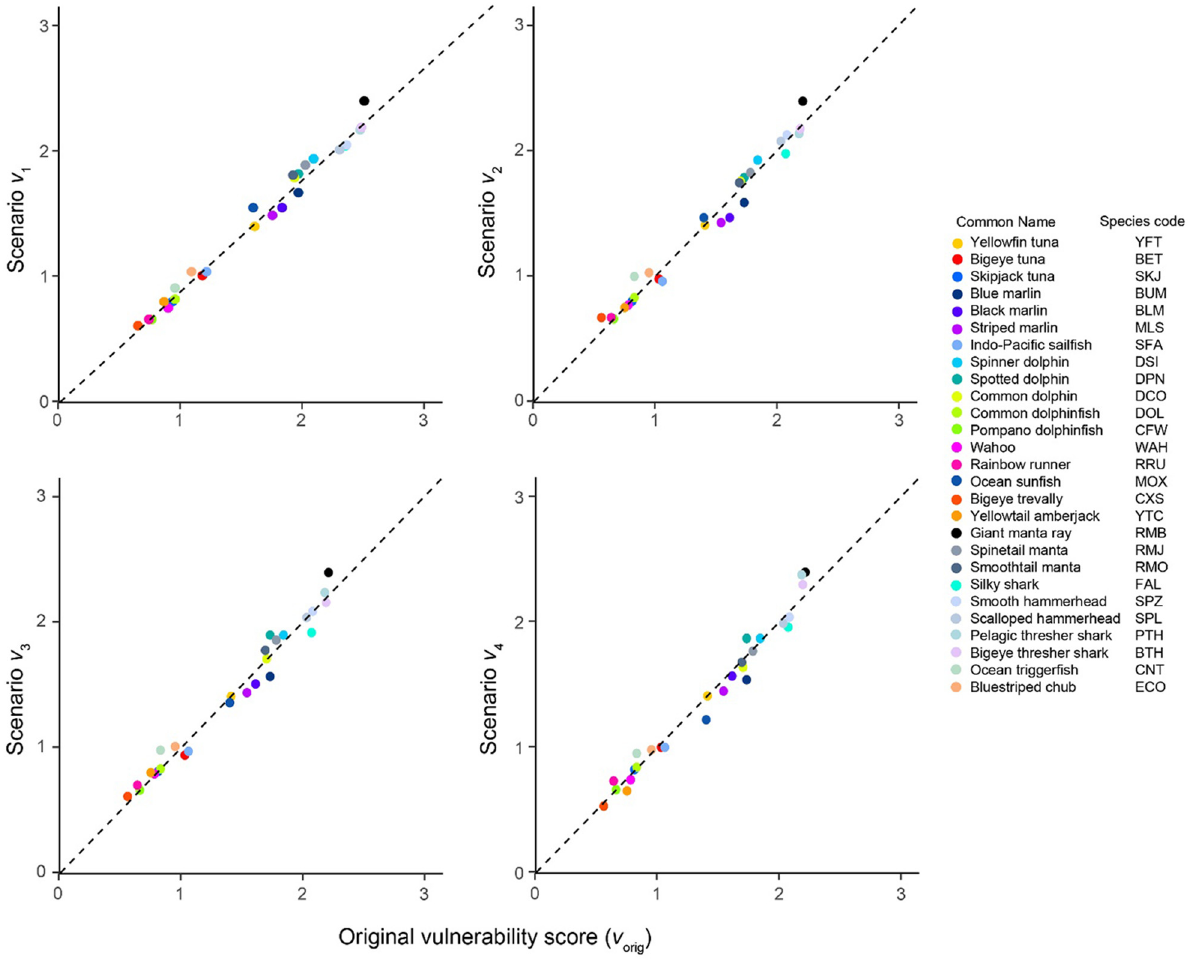
Fig. 4. Comparison of the original vulnerability scores ( v orig ) – all attributes included in the productivity-susceptibility analysis – with the four scenarios involving attribute removal: v 1 = no mean trophic level (TL); v 2 = attributes in v 1 and without the intrinsic rate of population growth ( r ); v 3 = attributes in v 2 and without maximum age ( A max ); v 4 = attributes in v 3 and without natural mortality ( M ). (For interpretation of the references to colour in this fi gure legend, the reader is referred to the web version of this